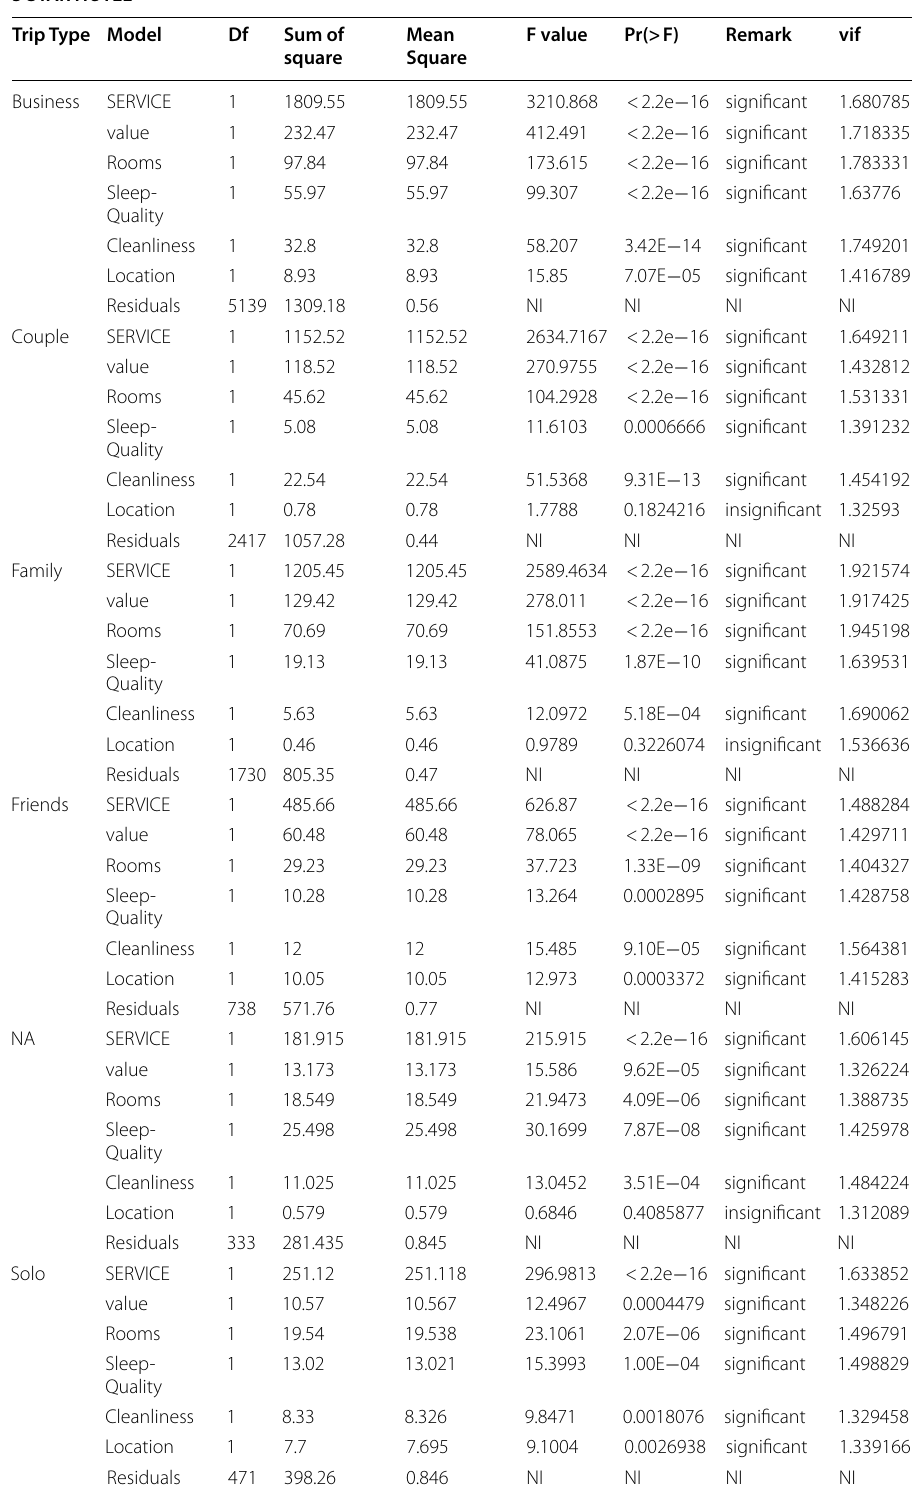
Table 9 Analysis of Variance of 5 star hotel class based on trip type 5 STAR